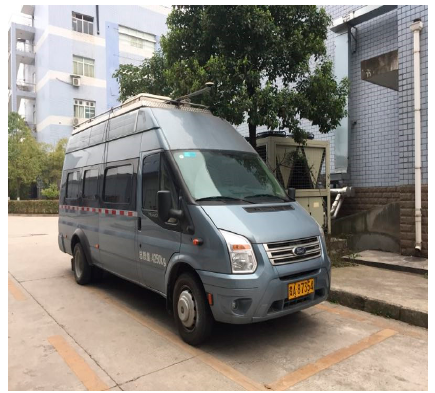
Figure 11. The navigation experiment vehicle.